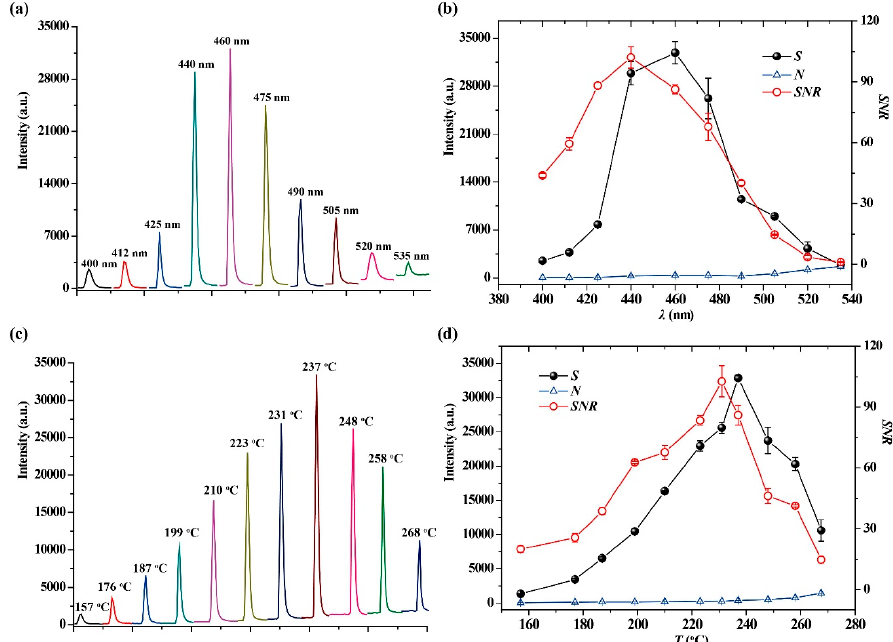
Figure 3. ( a ) The dynamic response curves of 2-butanone at different detection wavelengths. ( b ) The change trends of the values of S , N and SNR versus detection wavelengths. ( c ) The dynamic response curves of 2-butanone at different temperatures. ( d ) The change trends of the values of S , N and SNR versus temperature. Concentration of 2-butanone is 200 mg/m 3 .